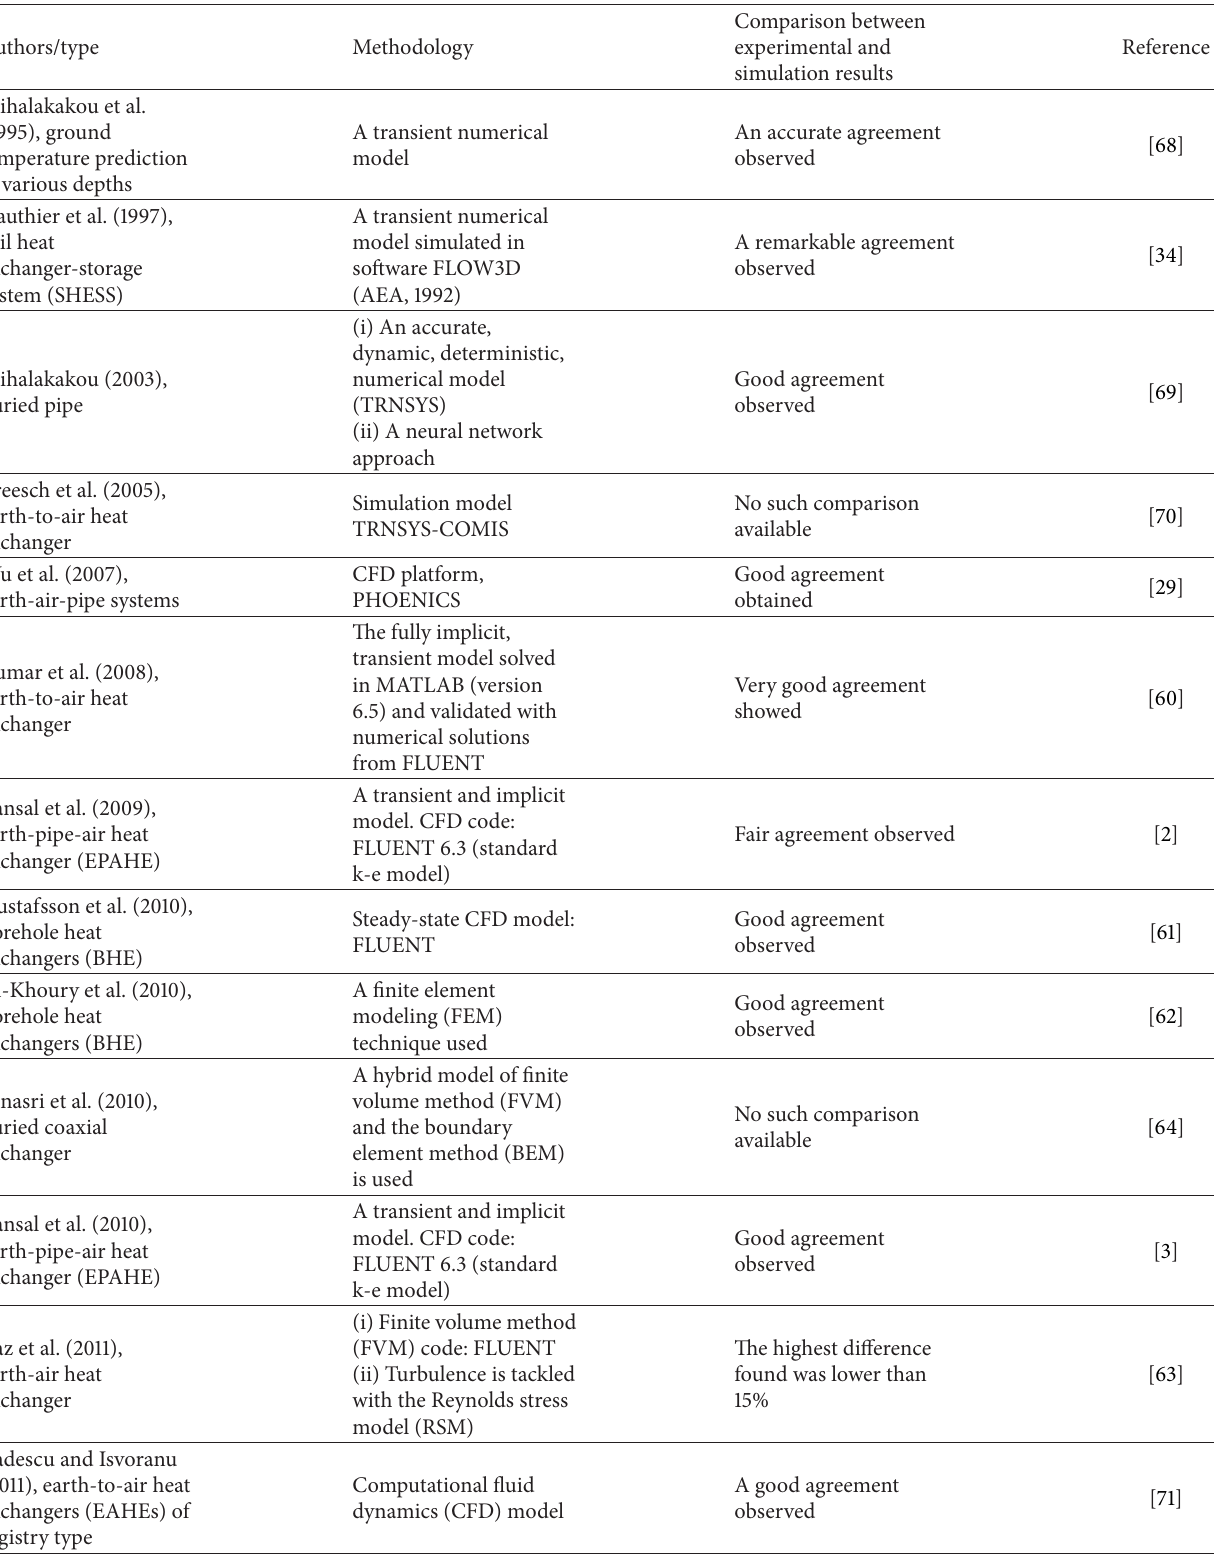
Table 3: Three-dimensional calculation models of EAHE